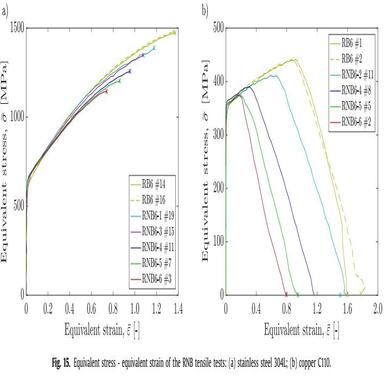
Maximum axial stress - equivalent strain of the RNB tensile tests: (a) stainless steel 304L; (b) copper C110.